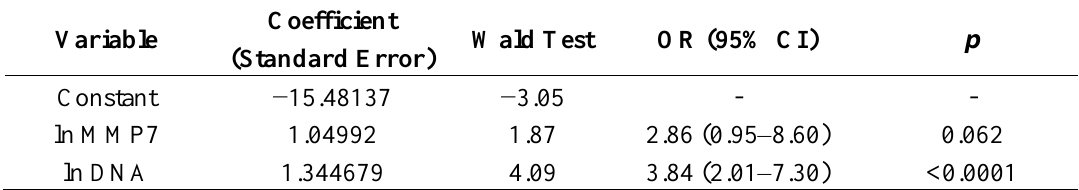
Table 6. Combined analysis of MMP-7 and free circulating DNA, considered as continuous variables in a multiple logistic regression model adjusted for age, gender and smoking habits of NSCLC patients compared to the other lung diseases (except IPF) and healthy donors.